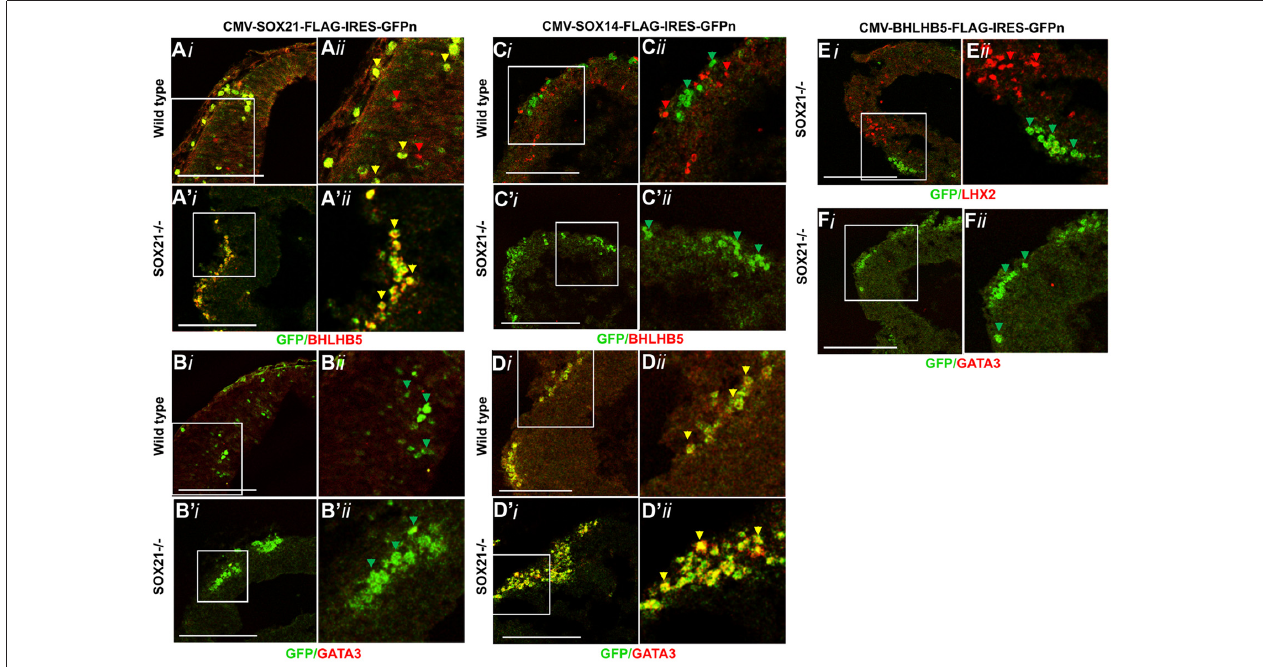
FIGURE 9 | Overexpression of SOX21, SOX14 and BHLHB5 through in utero electroporation. Wild type embryos ( i,ii ) were in utero electroporated at E11 with Plasmids encoding CMV-SOX21-FLAG-IRES-GFP n , CMV-SOX14-FLAG-IRES-GFP n and CMV-BHLHB5-IRES-GFP n . The immunostaining of the embryos with BHLHB5 illustrated that ectopic expression of this gene could be achieved when SOX21 was overexpressed (A) and not with SOX14 (C) . Expression of GATA3 on the other hand was only induced when SOX14 was overexpressed (D) and not with SOX21 (B) . These experiments were repeated on SOX21 − / − embryos ( iii,iv ) providing similar findings (A’,B’,C’,D (cid:48) ) . Interestingly, ectopic expression of BHLHB5 was unable to induce either the GABAergic or Glutamatergic lineage as show by staining of the embryos with GATA3 or LHX2 (E,F) . Scale bar, 75 µ m.